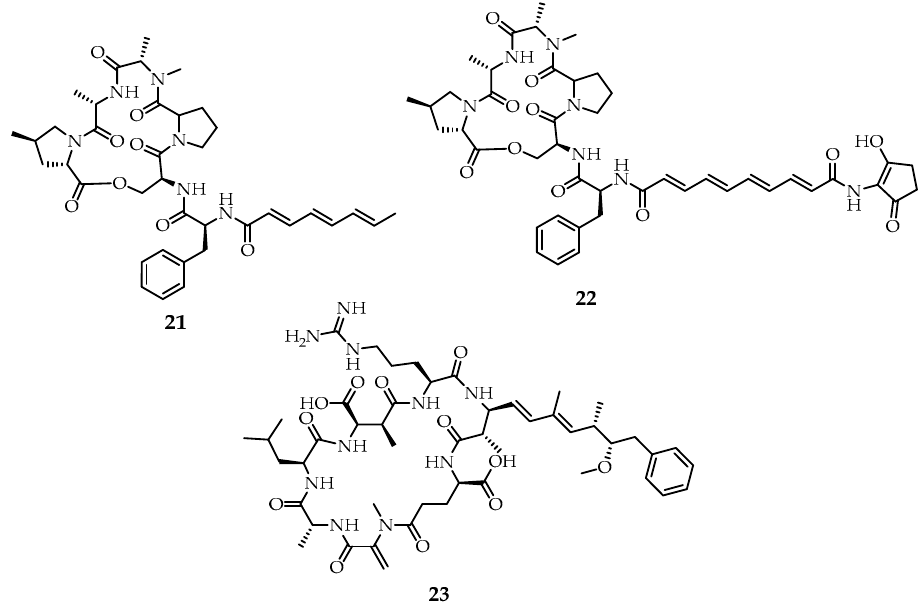
Figure 7. Structures of acyldepsipeptides 21 - 23 .